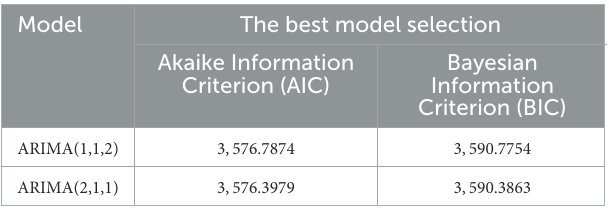
TABLE 5 Comparison of the possible ARIMA